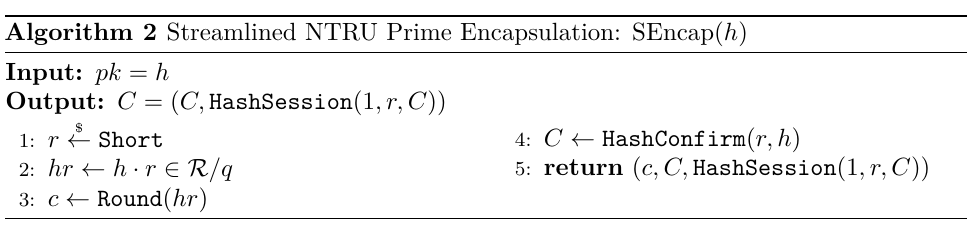
Algorithm 2 Streamlined NTRU Prime Encapsulation: SEncap( h )